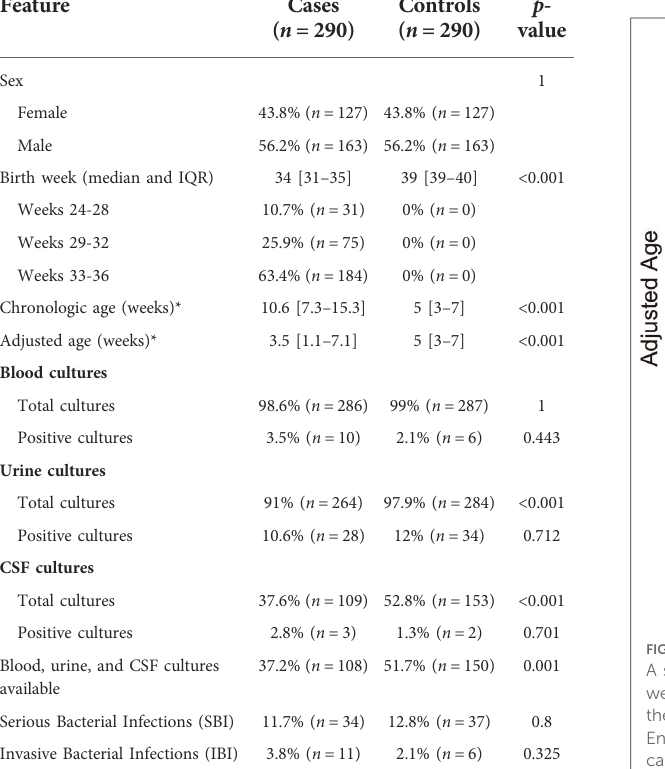
TABLE 1 Summary statistics for the 290 cases and 290 controls included in the study.